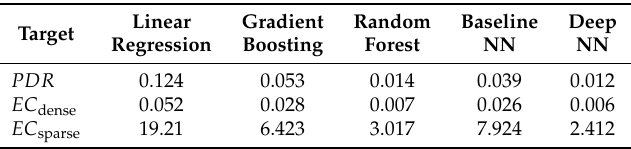
Table 5. RMSE of different machine learning